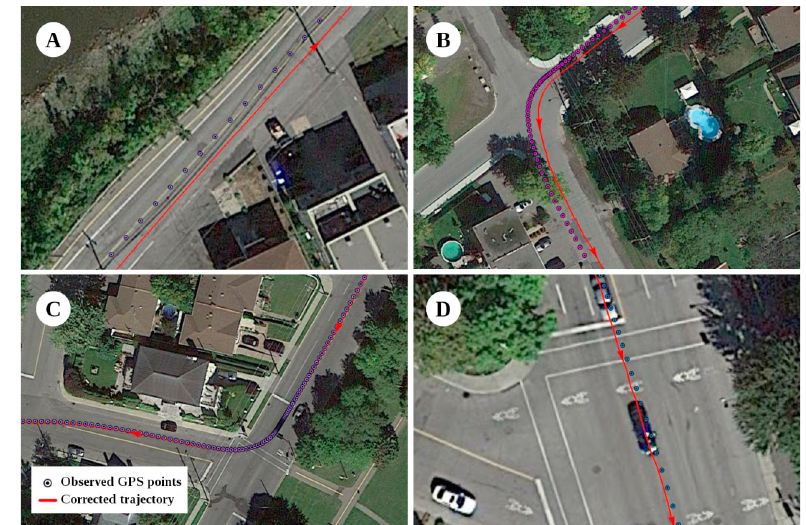
Fig. 7. Snapshots of the uncorrected GPS points (purple dots) and the corrected trajectory (red line) for (A and B) northeast, (C) southeast, and (D) east of the study area, where the correction is higher. Arrows on the trajectory show the direction of the driving. These locations are marked by yellow circles in Fig.